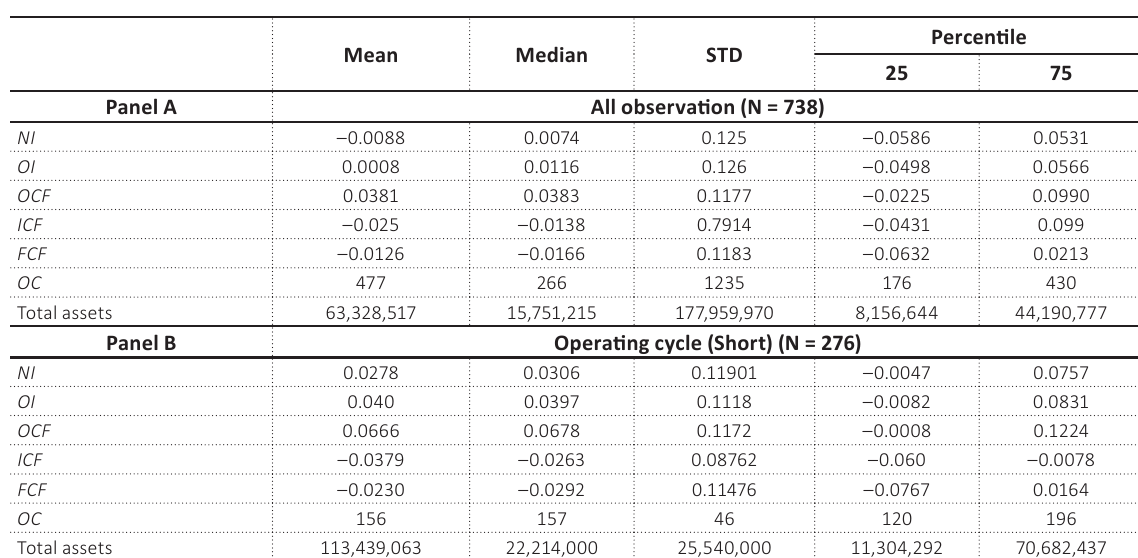
Table 1. Descriptive